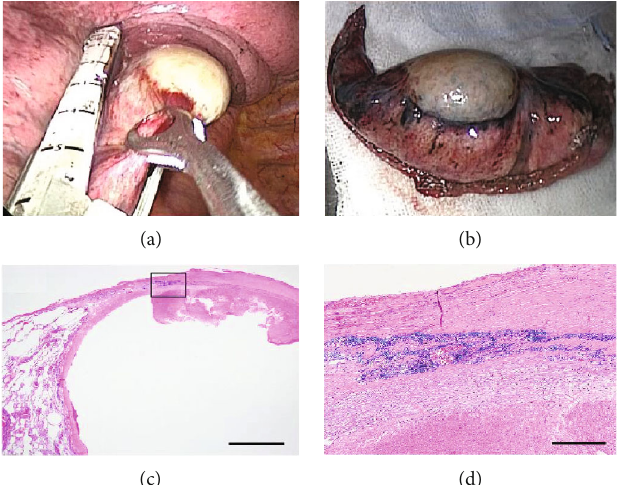
Figure 2: (a) Intraoperative picture of the subpleural mass, with stapler applied. (b) Wedged-out section of the left lower lobe, showing the subpleural mass. (c) Microphotographs of sections stained with Victoria blue and HE stain. (d) High-power fi eld of the rectangle in (c). The elastic layer of the visceral pleura is stained in blue. The hematoma was located inside the visceral pleura, indicating that the lesion is intrapulmonary. Scale bars in (c, d) are 2mm and 250 μ m,